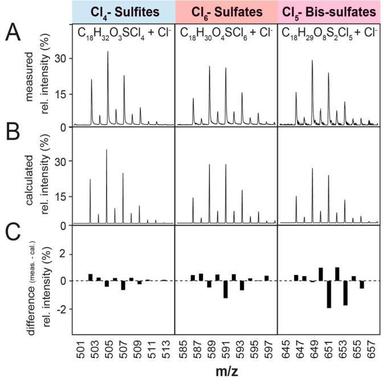
Comparison of measured and calculated isotope clusters of chlorinated sulfite-, sulfate- and bis-sulfate-diesters. Chloride-adduct ions - of measured (A) and calculated (B) isotope clusters of Cl4-sulfites (blue), Cl6-sulfates (red) and Cl5-bis-sulfates (magenta) are compared as found in F46–F54. Differences of measured and modeled signal intensities are also shown (C). Respective formulae are also given. (For interpretation of the references to color in this figure legend, the reader is referred to the Web